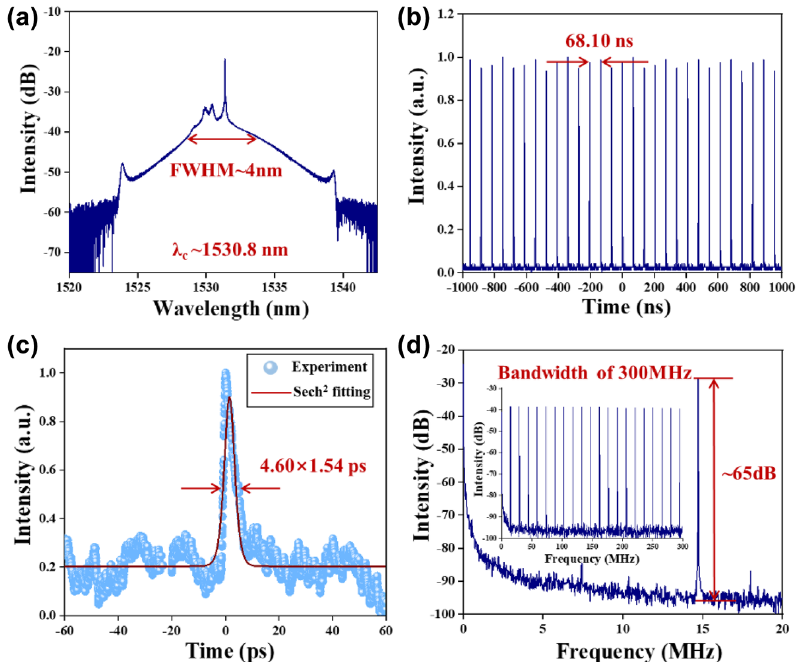
Figure4: TheoutputcharacteristicsofCr based SA conventional soliton mode-locked operation. (a) Emission optical spectrum. (b) Pulse train. (c) Measured and fitted autocorrelation trace. (d) RF spectrum is locatedat14.74 MHz.(Insetofd)RFspectrum recorded within 300 MHz